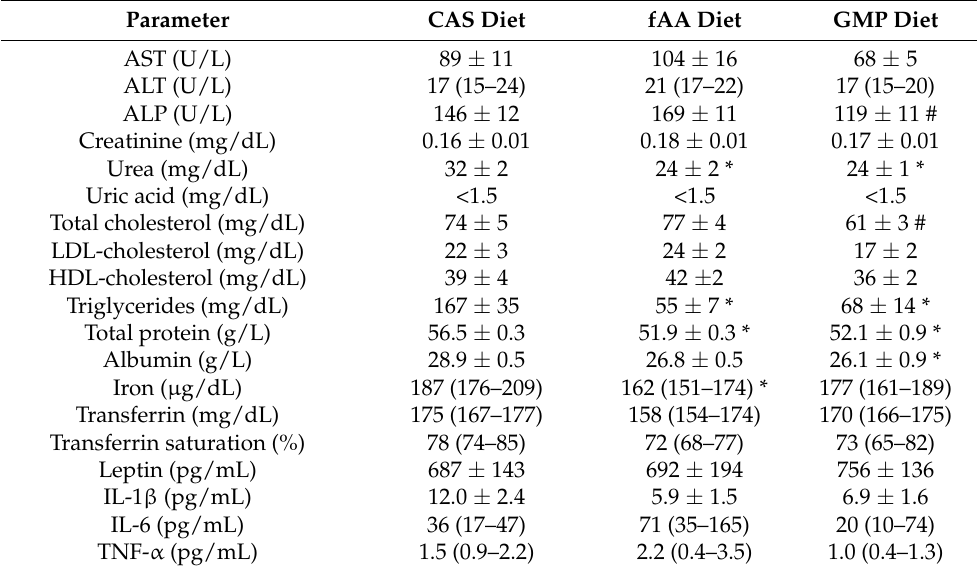
Table 1. Biochemical parameters of the control diet (CAS diet) and the experimental diets (fAA diet and GMP diet).